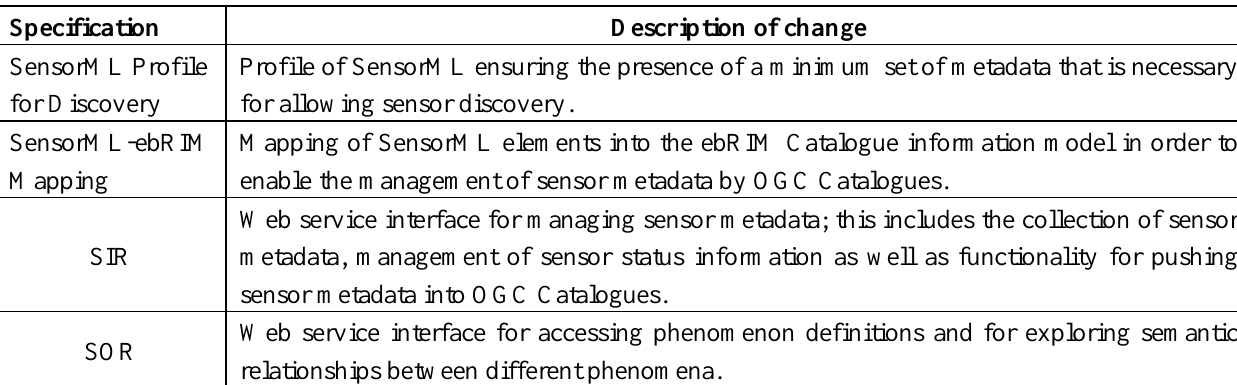
Table 6. Major advancements introduced by discovery